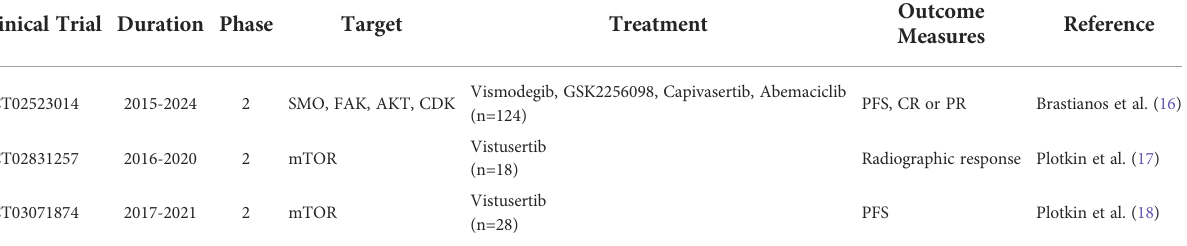
TABLE 2 Phase 2 clinical trials targeting genetic mutations in